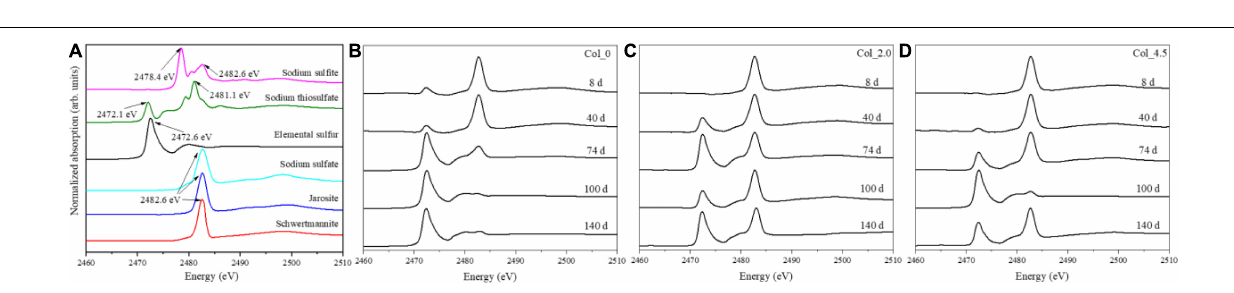
FIGURE 5 | S K-edge XANES spectra for the reference samples (A) , and the bottom residues during cultivation without (B) and with additions of 2.0 mM (C) and 4.5 mM (D)